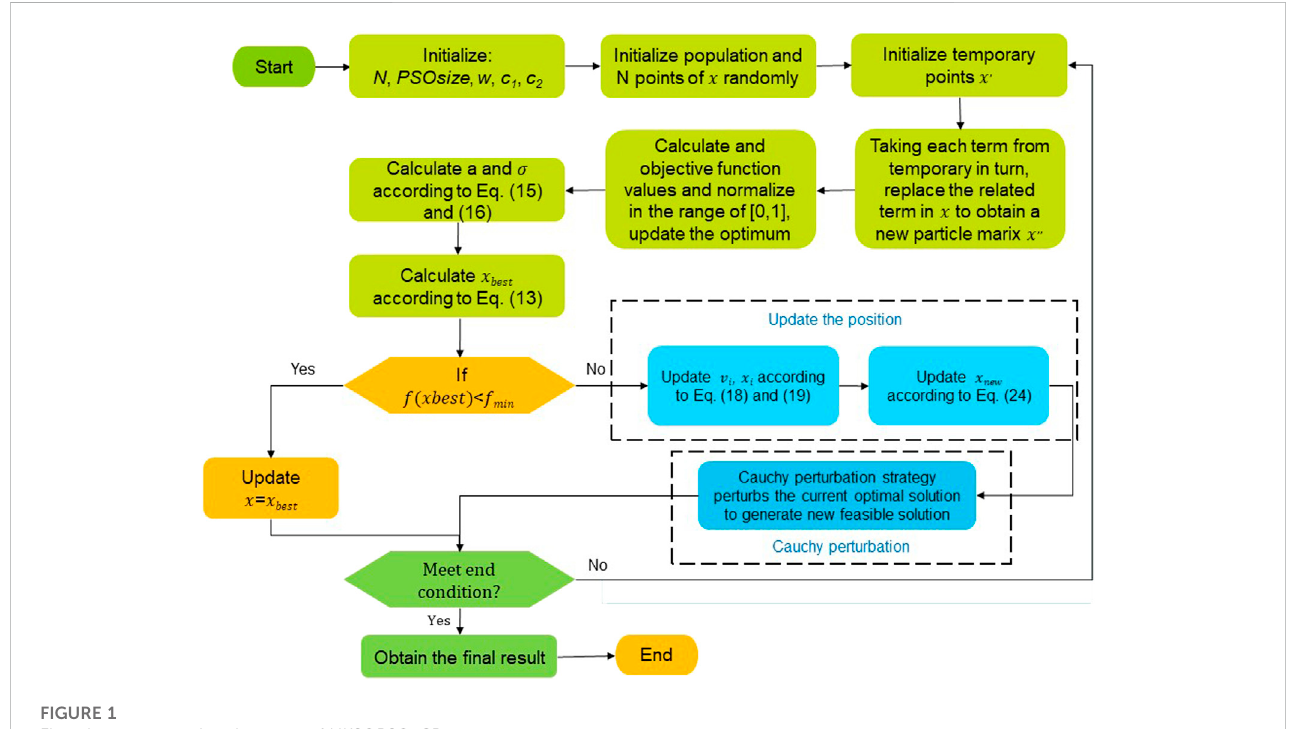
FIGURE 1 Flowchart representing the steps of